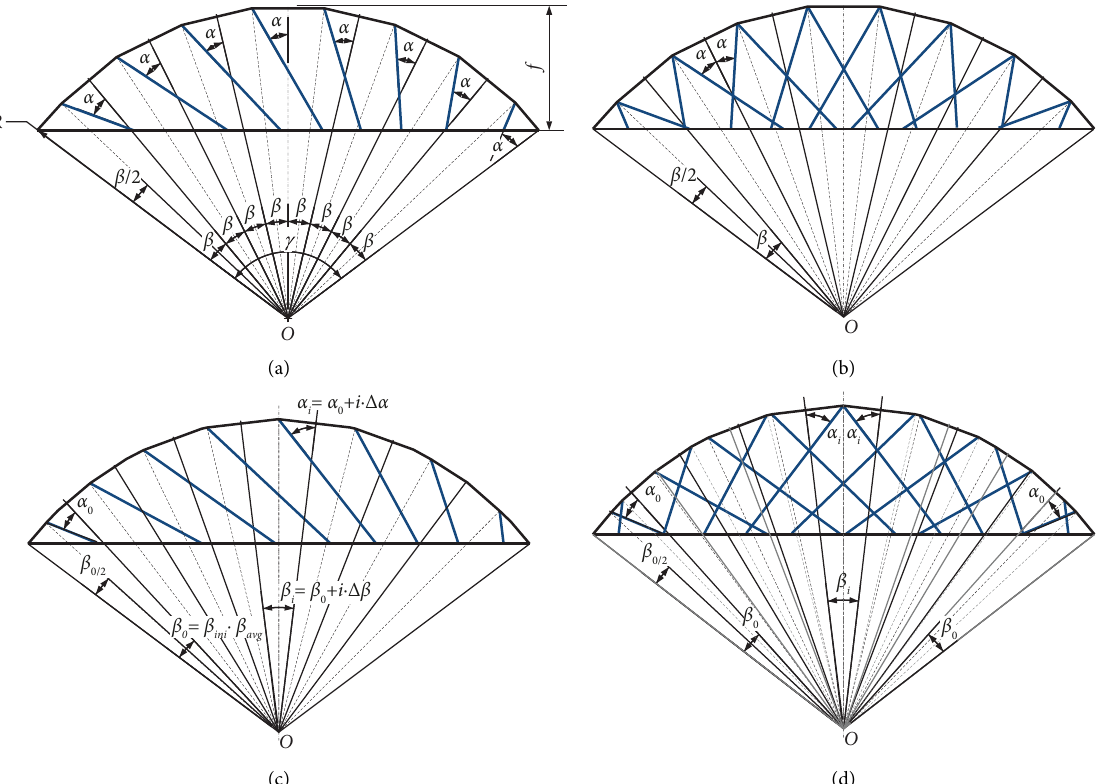
Figure 2: Algorithm of the bridge scheme generation: (a) Initial scheme of hangers at constant angles α and β , (b) Final scheme–obtained by the mirror image; (c) and (d) the same schemes at varying